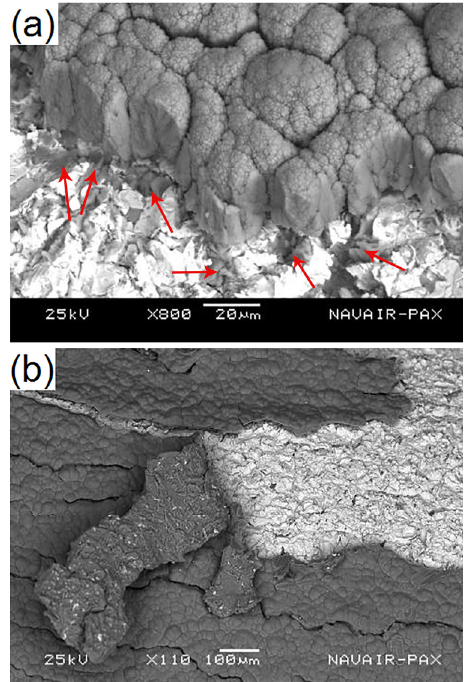
Fig. 13 Images after bend adhesion test. (a) Oblique view of fractured IVD-Al coating and exposed substrate, showing remnant of Al on 4130 steel substrate (arrows). (b) Non-aqueous electroplated Al coating peeling away from 4130 steel substrate at which the bright flecks at the underside of the coatings are the Fe particles that were pulled from the substrate. Reproduced with permission from Ref. [24], Licensed under Distribution Statement A, 2011.